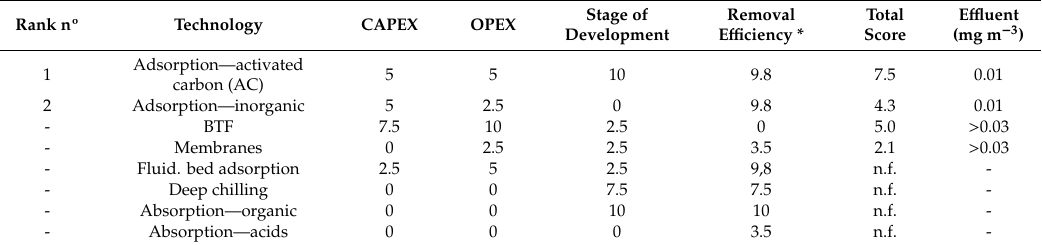
Table 5. Treatment alternatives proposed by BiogasApp_EDSS, rating obtained in each considered criterion, total score obtained considering same weight for each criterion (25% each) and e ffl uent concentration